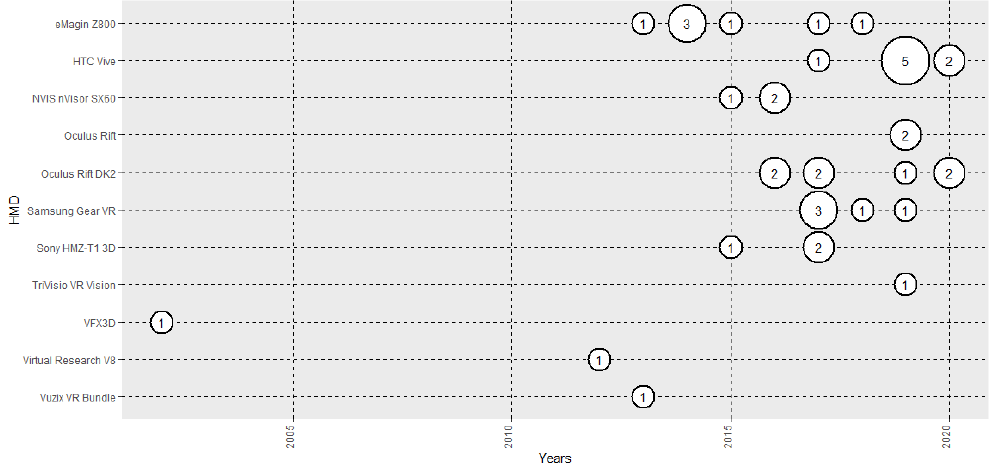
Figure 6. Evolution of the number of papers published each year based on head-mounted display (HMD) used.